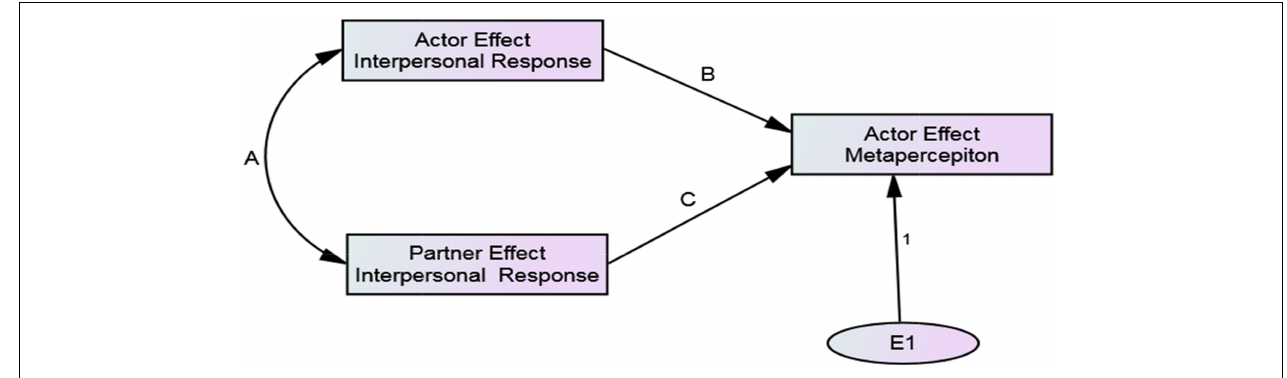
FIGURE 2 | ARRMA model at the individual level of analysis. Parameters B, A, and C are assumed reciprocity, reciprocity, and metaperception accuracy, respectively.